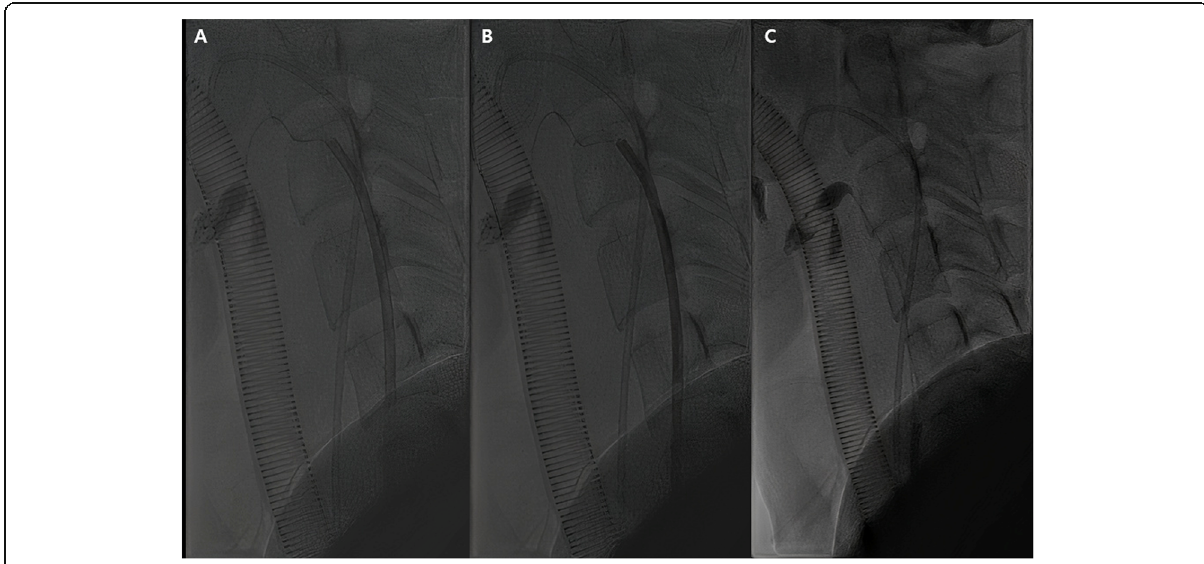
Fig. 2 Lateral-view fluoroscopic spot image of the neck. A Microballoon catheter stuck to the vessel wall due to the glue cast is seen ( B ) The outer guiding catheter filled with glue is noted. C After pulling out the guiding catheter, the stuck microballoon was